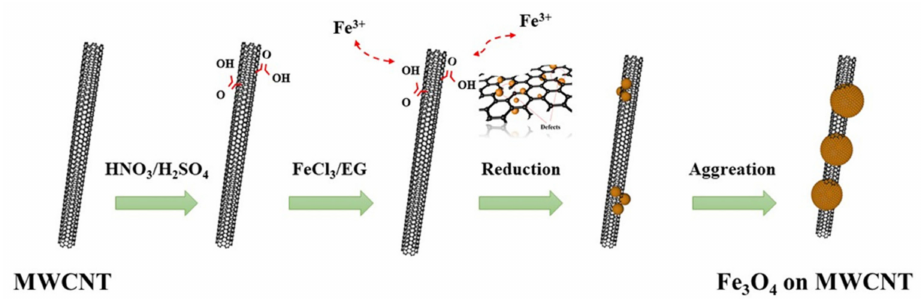
Figure 1. Synthesis strategy of Fe 3 O 4 /MWCNT